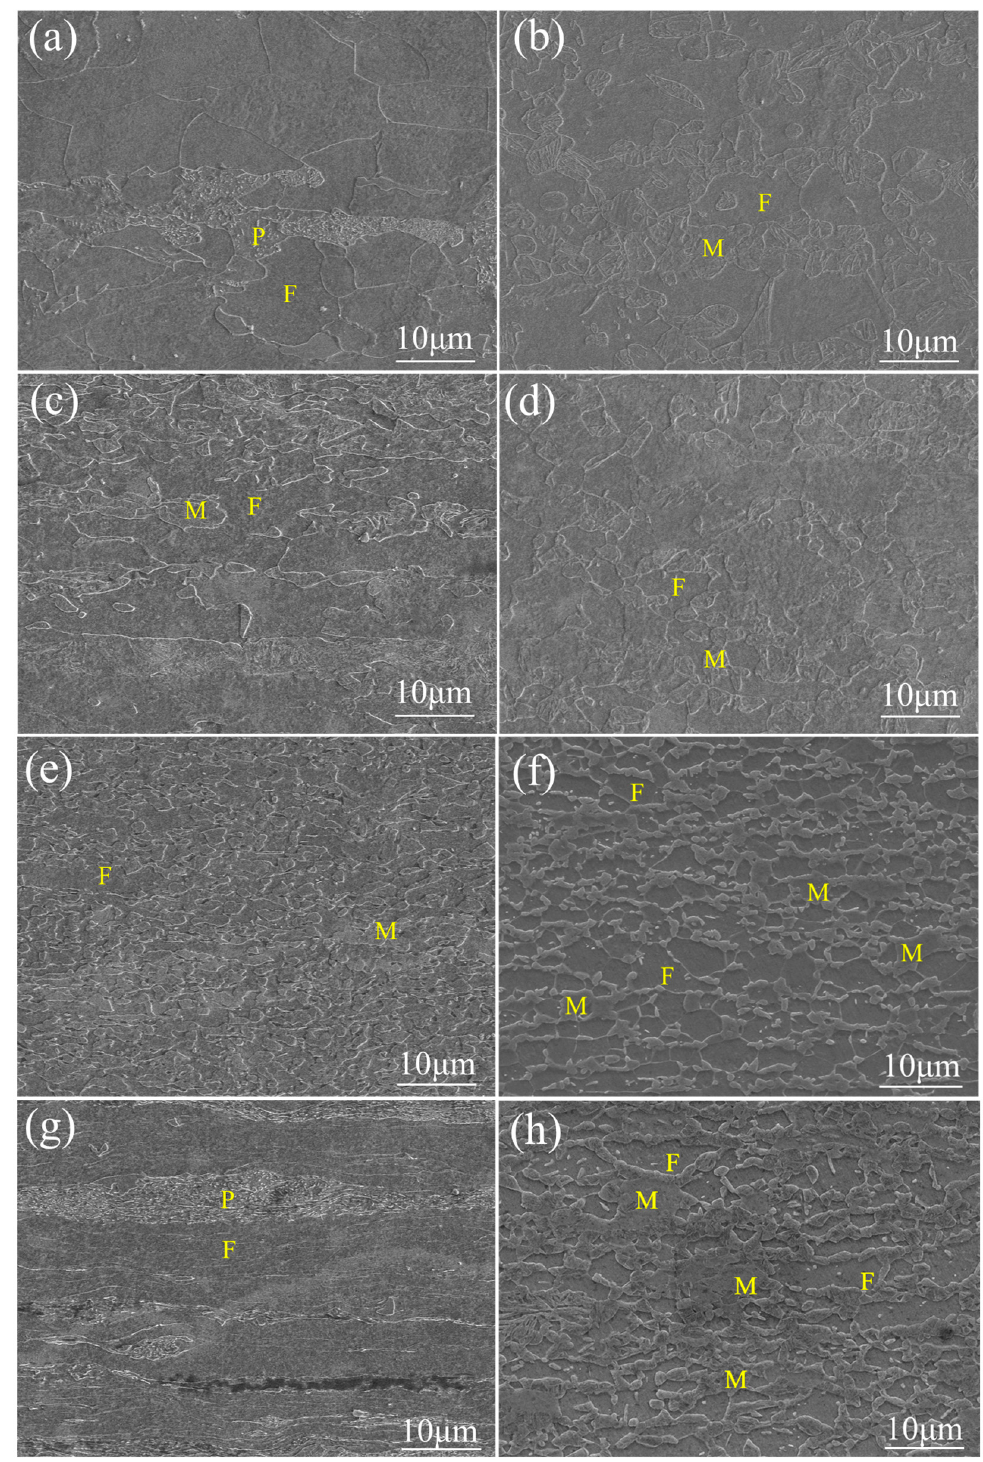
Figure 3. Microstructure of ( a ) CR27; ( b ) MS27; ( c ) CR54; ( d ) MS54; ( e ) CR81-1; ( f ) MS81; ( g ) CR81-2; and ( h ) SS81, M (martensite), F (ferrite), P (pearlite).